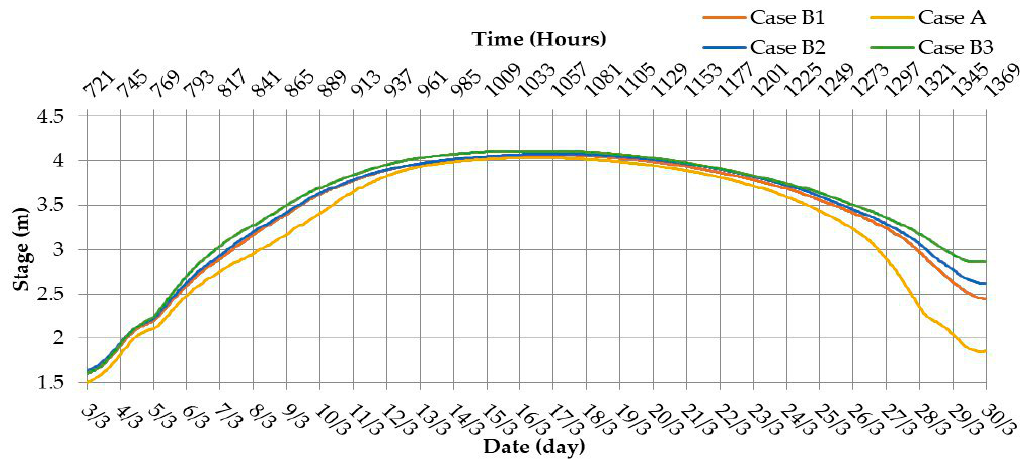
Figure 19. The stage in section no. 92 during the period of wave occurrence.